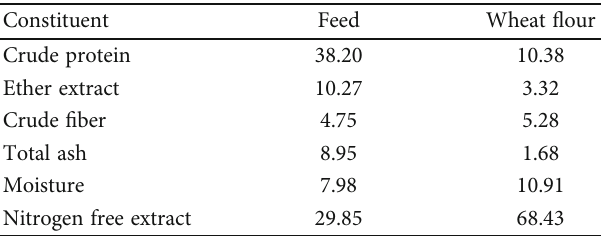
Table 1: Proximate analysis of experimental feed and carbon sources used in the